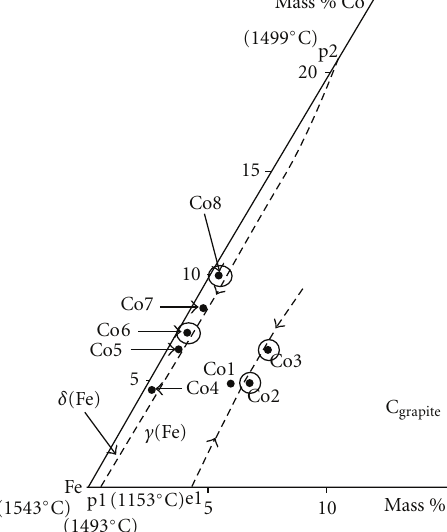
Figure 1: Liquidus surface projection of the Fe-Co-C system in the iron-rich corner (metastable system) [1] showing the studied alloys (encircled).